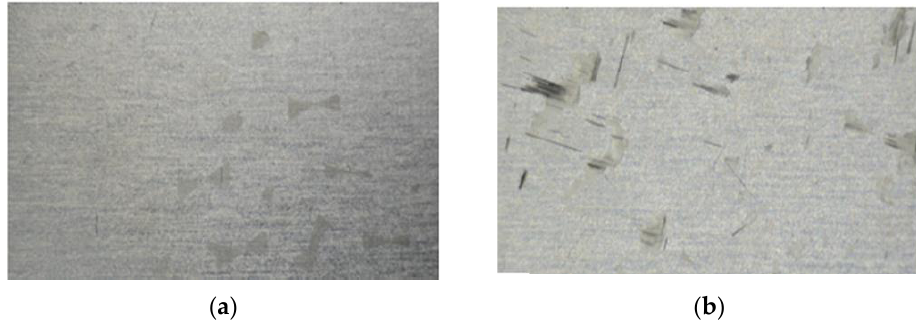
Figure 10. Carbon/epoxy delamination: ( a ) double strap match lap joint; ( b ) double strap mismatch lap joint.